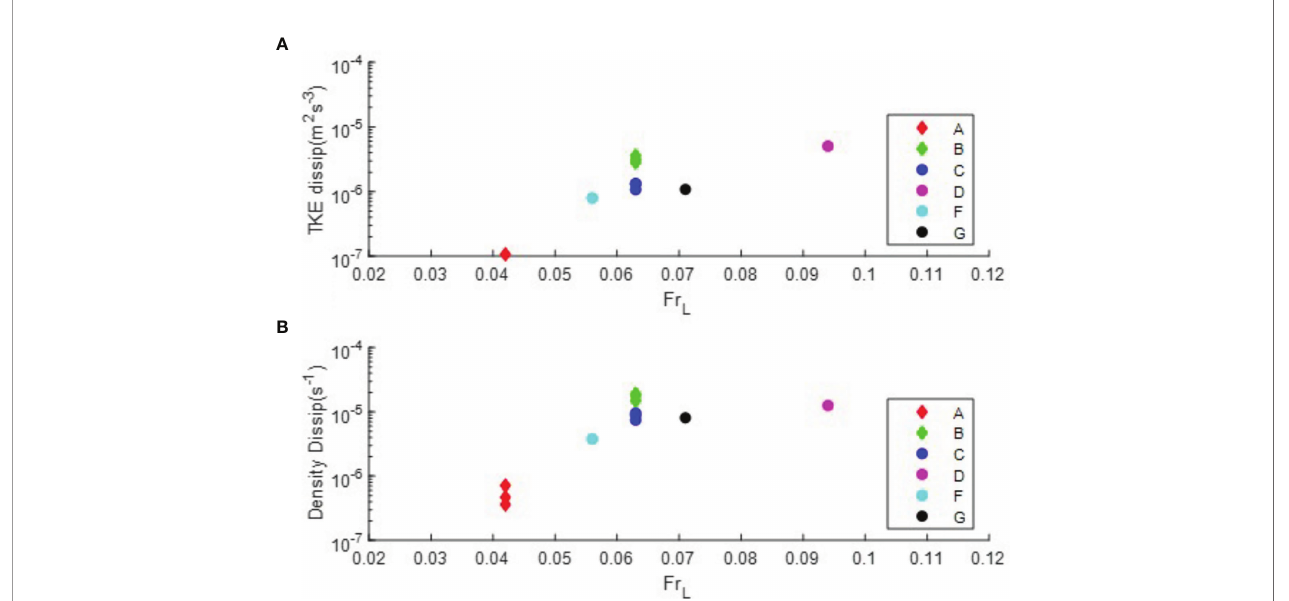
FIGURE 13 | Diagrams show Fr L versus (A) the depth-averaged TKE dissipation rate (unit: m 2 s -3 ) and (B) the depth-averaged normalized density dissipation rate (unit: s -1 ).